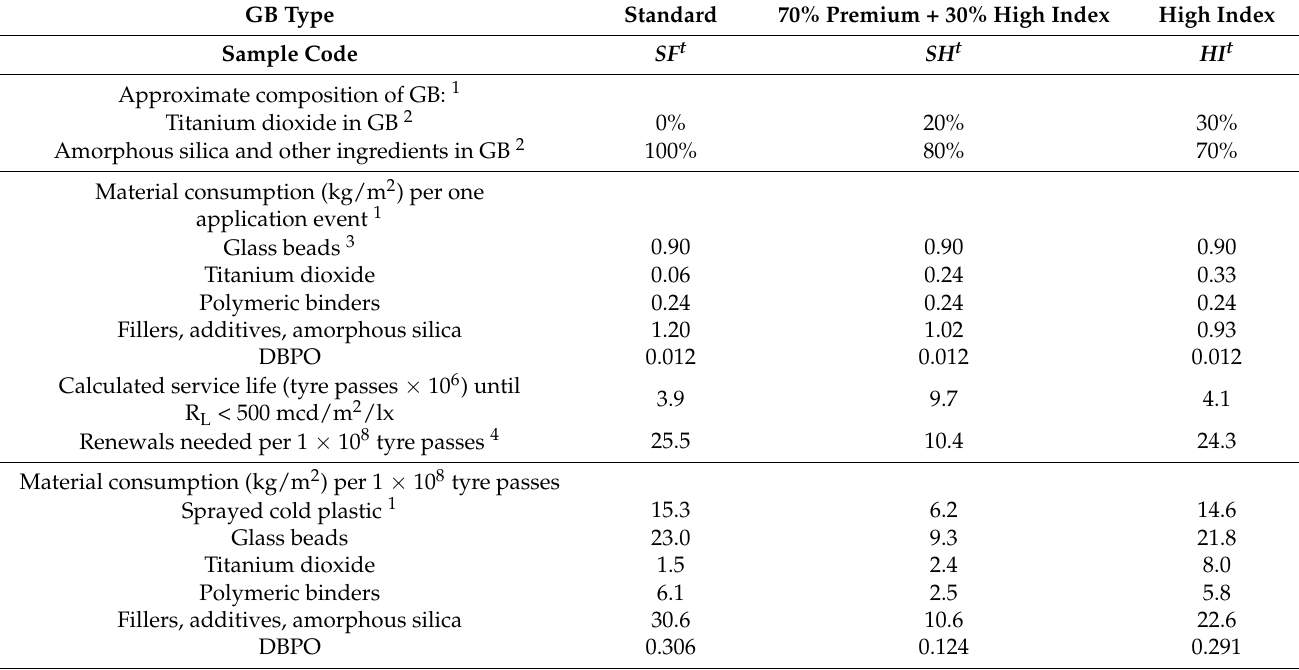
Table 7. Material consumption (turntable testing).